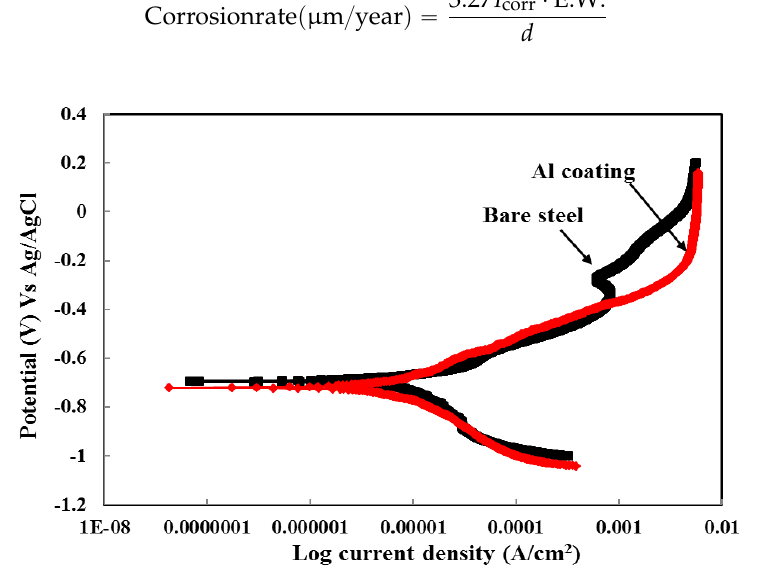
Figure 5. Potentiodynamic studies of samples in the SAE J2334 solution after 1 h of exposure. Table 4. Electrochemical parameters extracted from potentiodynamic polarization curves in the SAE J2334 solution after 1 h of exposure.